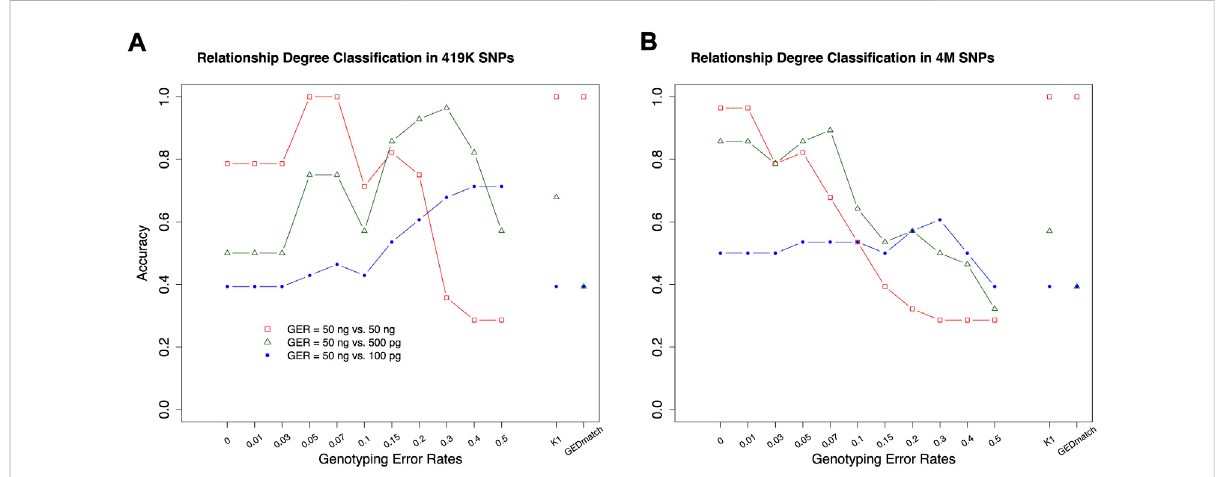
FIGURE 9 The accuracies of classifying relationship degrees with the UTAH family in Figure 1. The accuracies were estimated with the fi nal selected features for the relationship degrees in the simulated training and real test datasets (UTAH family) with different genotyping error rates. (A)